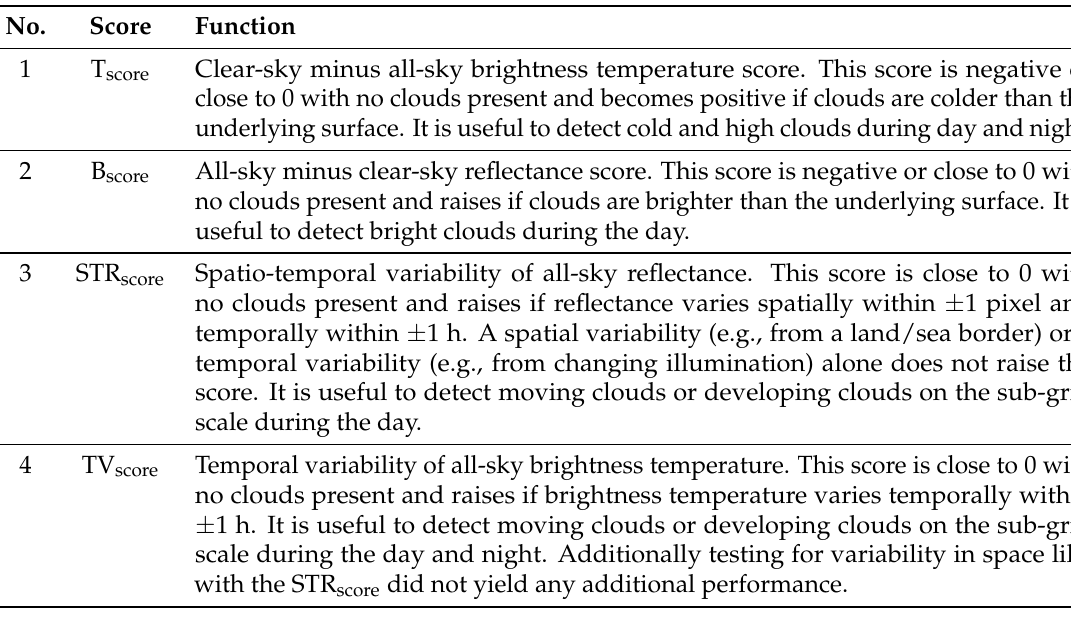
Table 1. Continuous scores utilized for cloud detection and Bayesian CFC